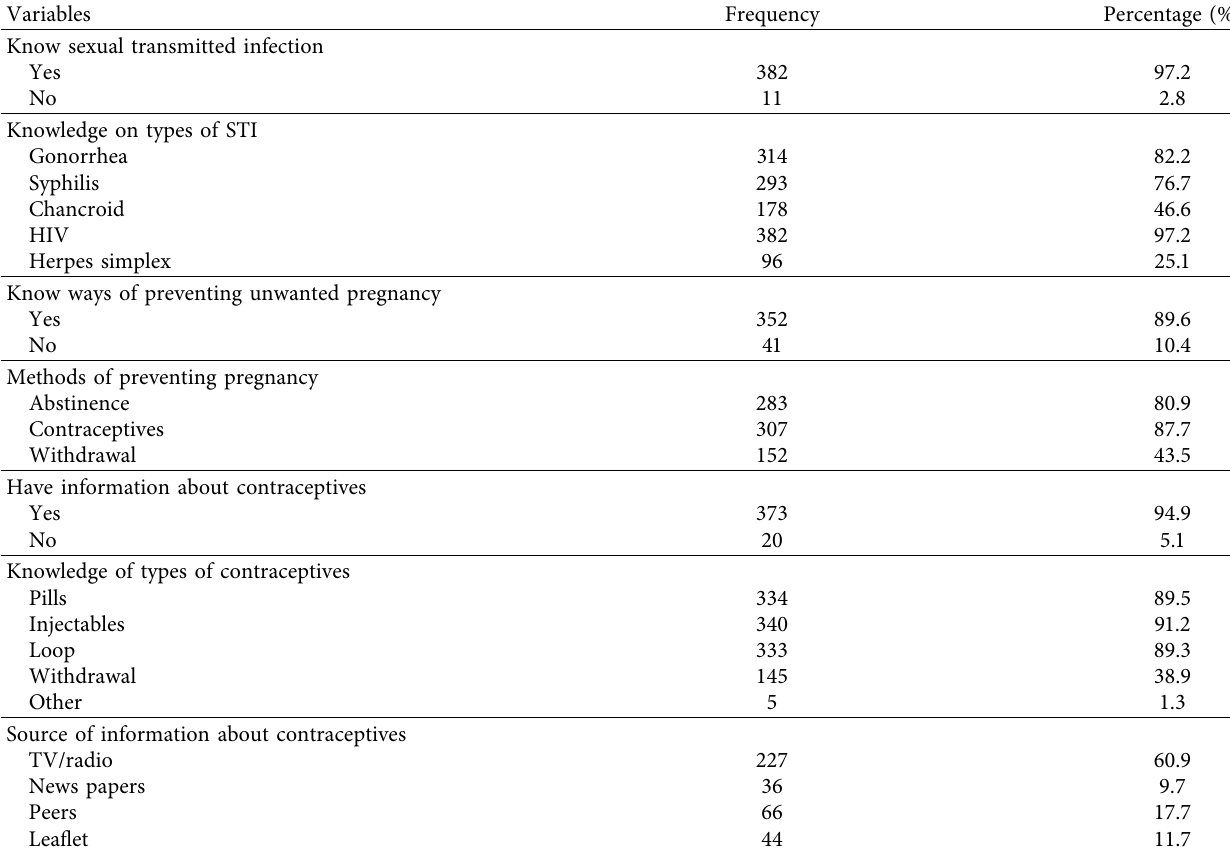
Table 3: Knowledge of STI and contraceptives among preparatory school female students, Assela, Ethiopia, 2015.